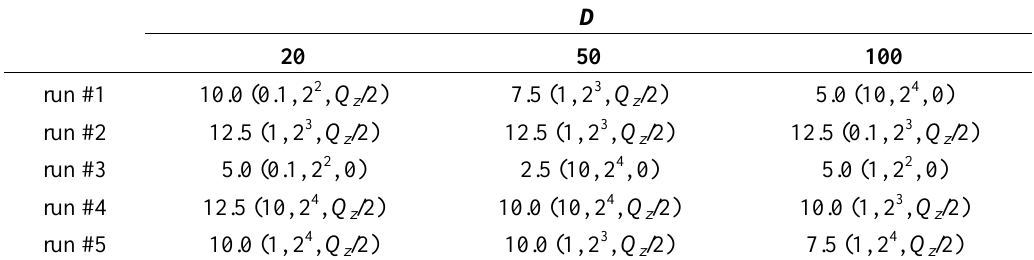
Table 4. Simulation results: problem A, tensor-RLS.